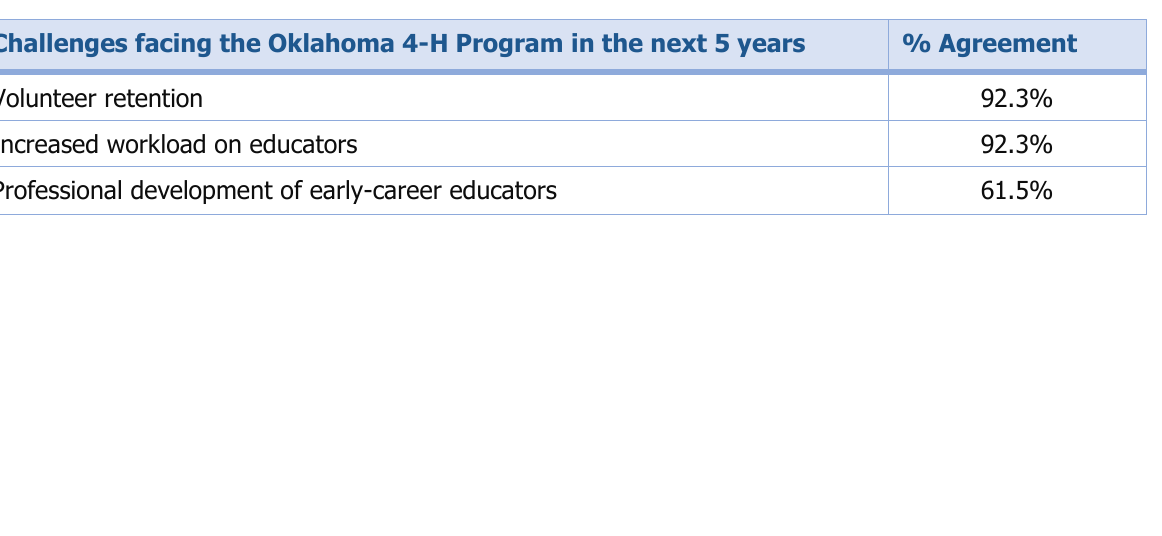
Table 3. Challenge Statements and Agreement Percentages in Round 3: Panel